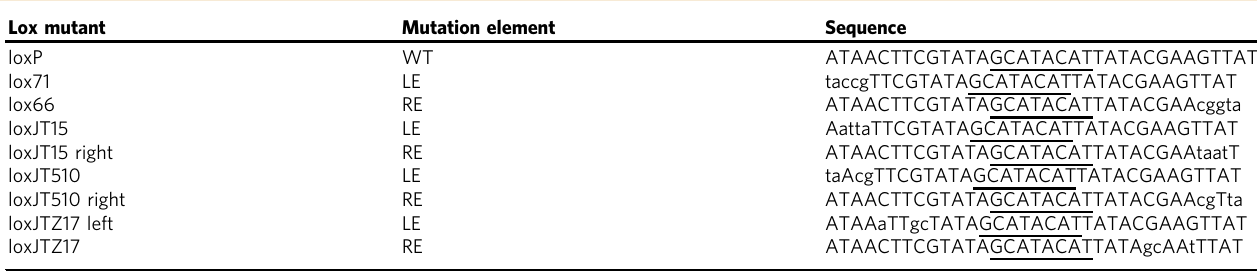
Uppercase indicates wild-type bases; lower case indicates mutation bases. Underline indicates spacer region LE left element, RE right element, WT wild